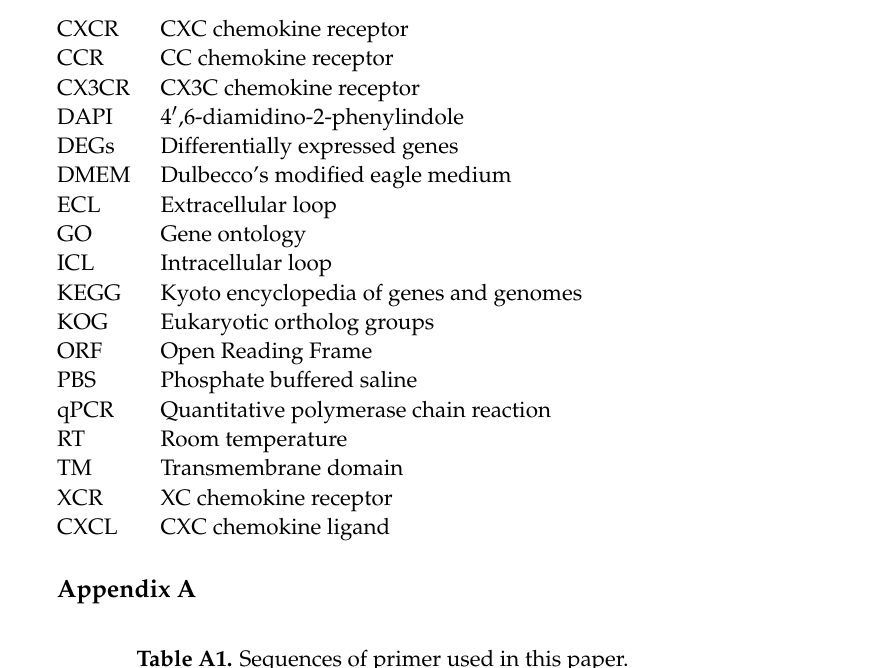
Table A1. Sequences of primer used in this